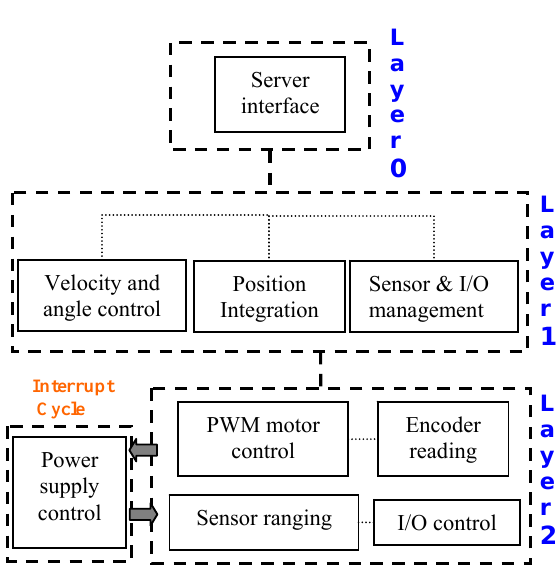
Fig. 10. Server operating system. Low-level tasks are motor control, sensor control and position integration. High-level tasks are encoder reading, PWM control and I/O control.